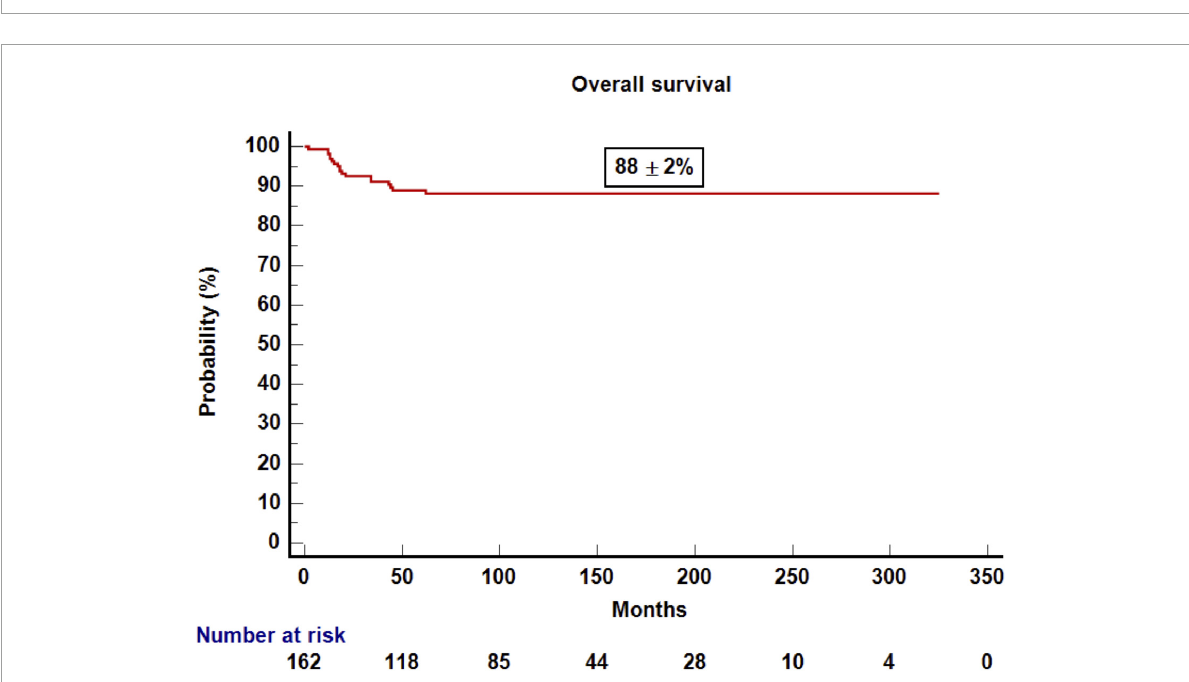
FIGURE2 Kaplan–Meier estimation of disease-free survival after 1 year post-transplantation.